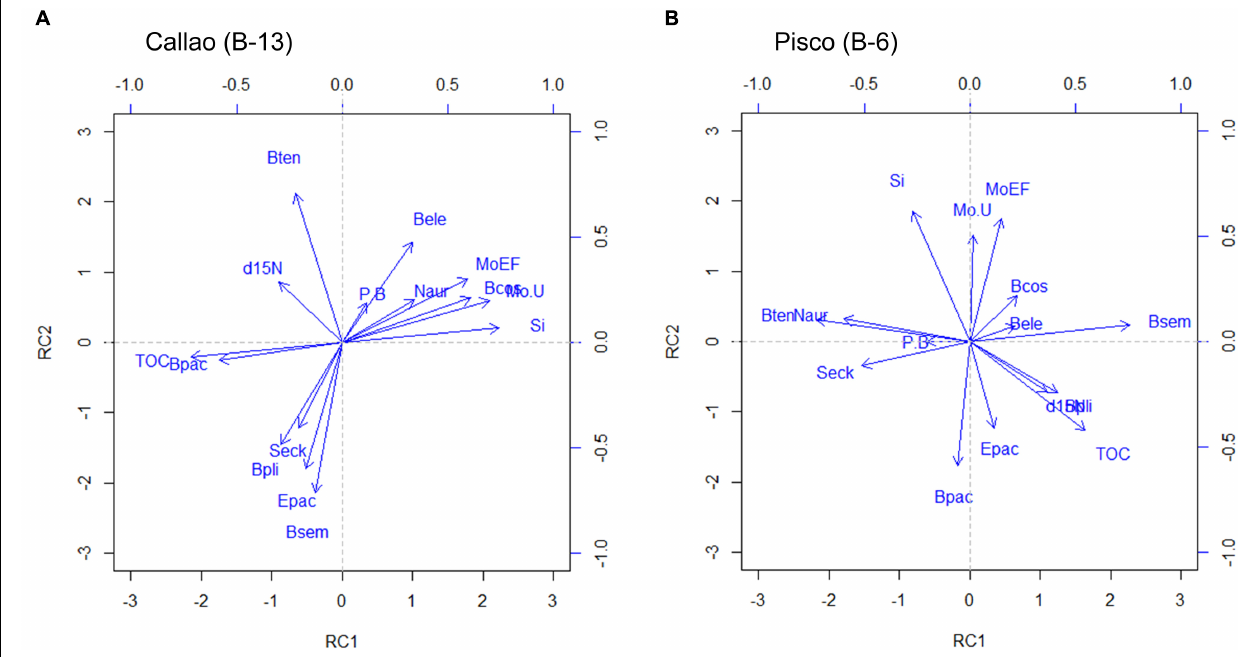
FIGURE 5 | Principal component analysis based on both geochemical and foraminiferal matrices for B-13 (A) (Callao; left) and B-6 (B) (Pisco; right). Geochemical proxies are: Total organic carbon (TOC), δ 15 N, biogenic silica (Si), Mo/U, Mo enrichment factor (Mo EF). Foraminiferal proxies are the same benthic species in Figure 4 , plus the planktonic to benthic ratio